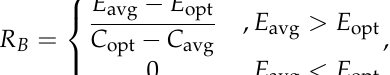
Figure 11. The comparison on the accuracy of 10-fold cross validation using linear regression and machine learning: ( a ) cooling demand; ( b ) heating demand.